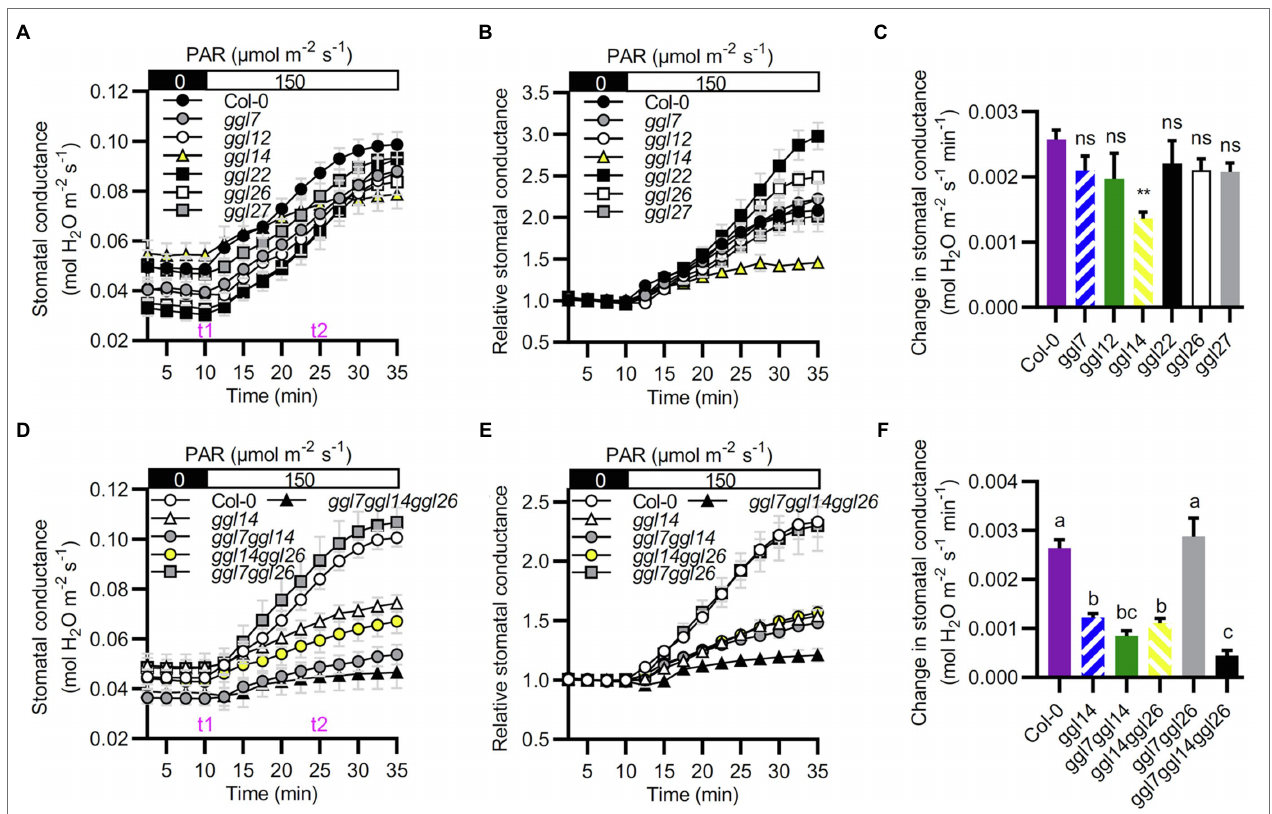
FIGURE 7 | GGL7 , GGL14 , and GGL26 show functional redundancy in stomatal dynamics during the dark-to-light transition. (A–C) Time-resolved stomatal conductance responses to dark to light transitions in Col-0 and ggl single mutant plants. (B) Relative stomatal conductance. Normalized stomatal conductance of (A) . (C) The initial rates of stomatal conductance changes in the period of t1 to t2 in (A) , presented as mol H 2 O m − 2 s − 1 min − 1 . Values are means ± SE ( n = 3 independent experiments, each with at least four leaves per genotype). ** p < 0.01; ns, no significant difference; Student’s t -test. (D–F) Time-resolved stomatal conductance responses to dark to light transitions in Col-0, ggl14 , ggl7ggl14 , ggl14ggl26 , ggl7ggl26 , and ggl7ggl14ggl26 mutant plants. (E) Relative stomatal conductance. Normalized stomatal conductance of (D) . (F) The initial rates of stomatal conductance changes in the time of t1 to t2 in (D) , presented as mol H 2 O m − 2 s − 1 min − 1 . Values are means ± SE ( n = 3 independent experiments, each with at least four leaves per genotype). Different letters indicate statistically significant differences ( p < 0.05) by one-way ANOVA and Tukey’s test analyses. PAR: photosynthetically active